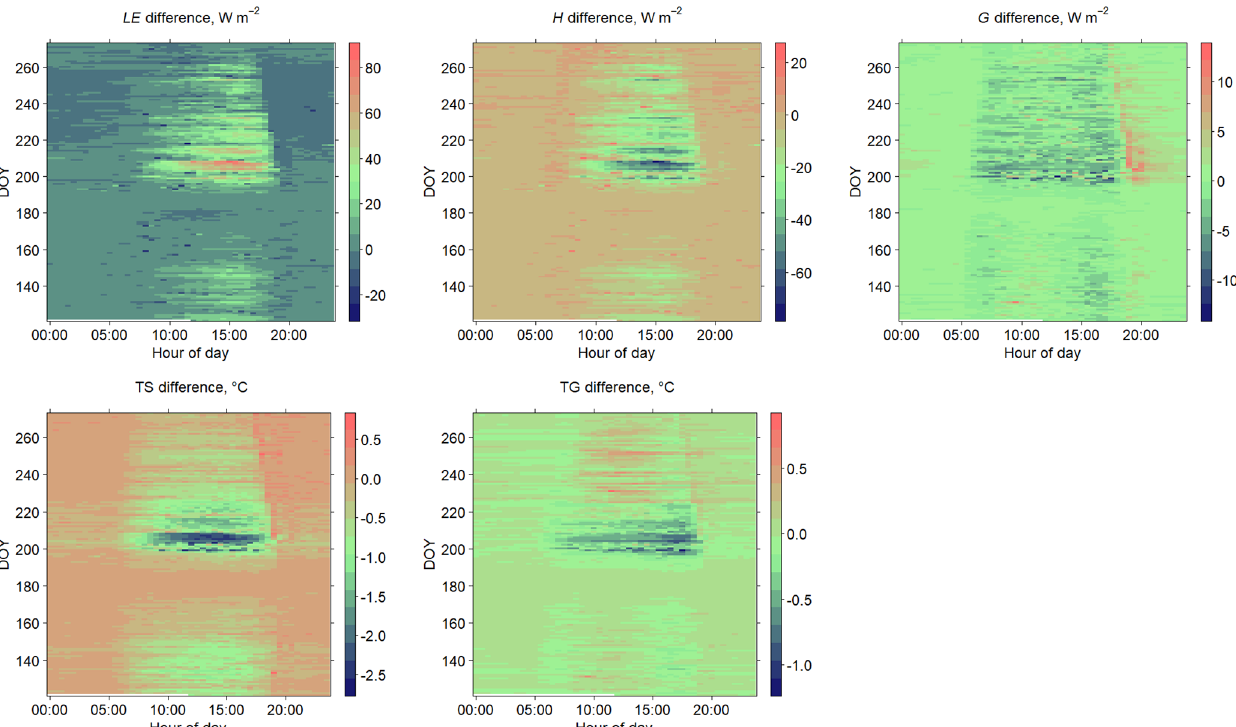
Figure 7. Differences in latent heat flux ( LE ), sensible heat flux ( H ), ground heat flux ( G ), mean surface temperature (TS) and mean ground temperature (TG) between Run 1 (generic crop) and Run 2 (weighted mean of early- and late-covering crops) simulations (Run 1–Run 2). Time is local